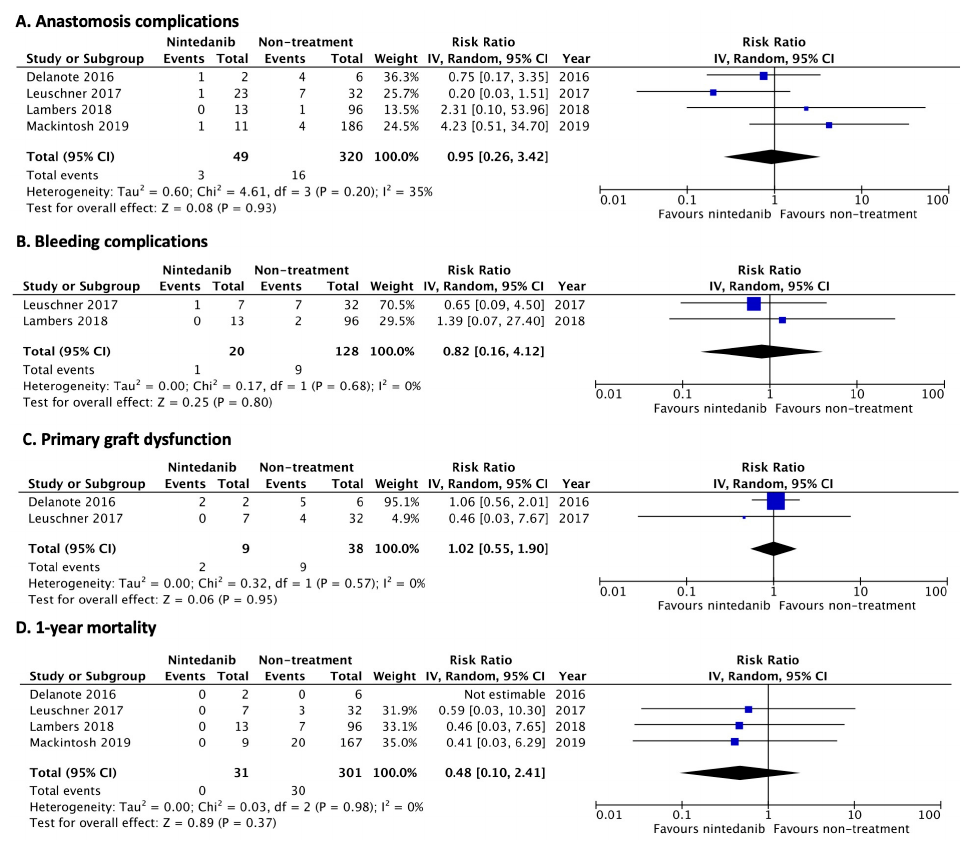
Figure 3. Forest plot of pooled risk ratio for nintedanib [12,21–23]. ( A ) anastomosis complications, ( B ) bleeding complications, ( C ) primary graft dysfunction at 72 h after transplantation, and ( D ) 1-year mortality after LT.